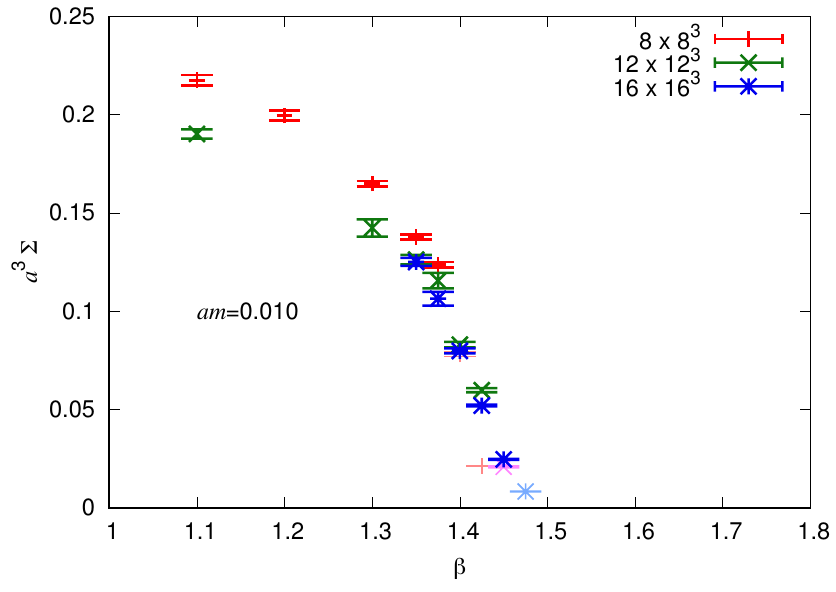
Figure 10 . Chiral condensate versus bare coupling (cid:12) = 4 =g 2 values of (cid:31) 2 /d.o.f value ( >